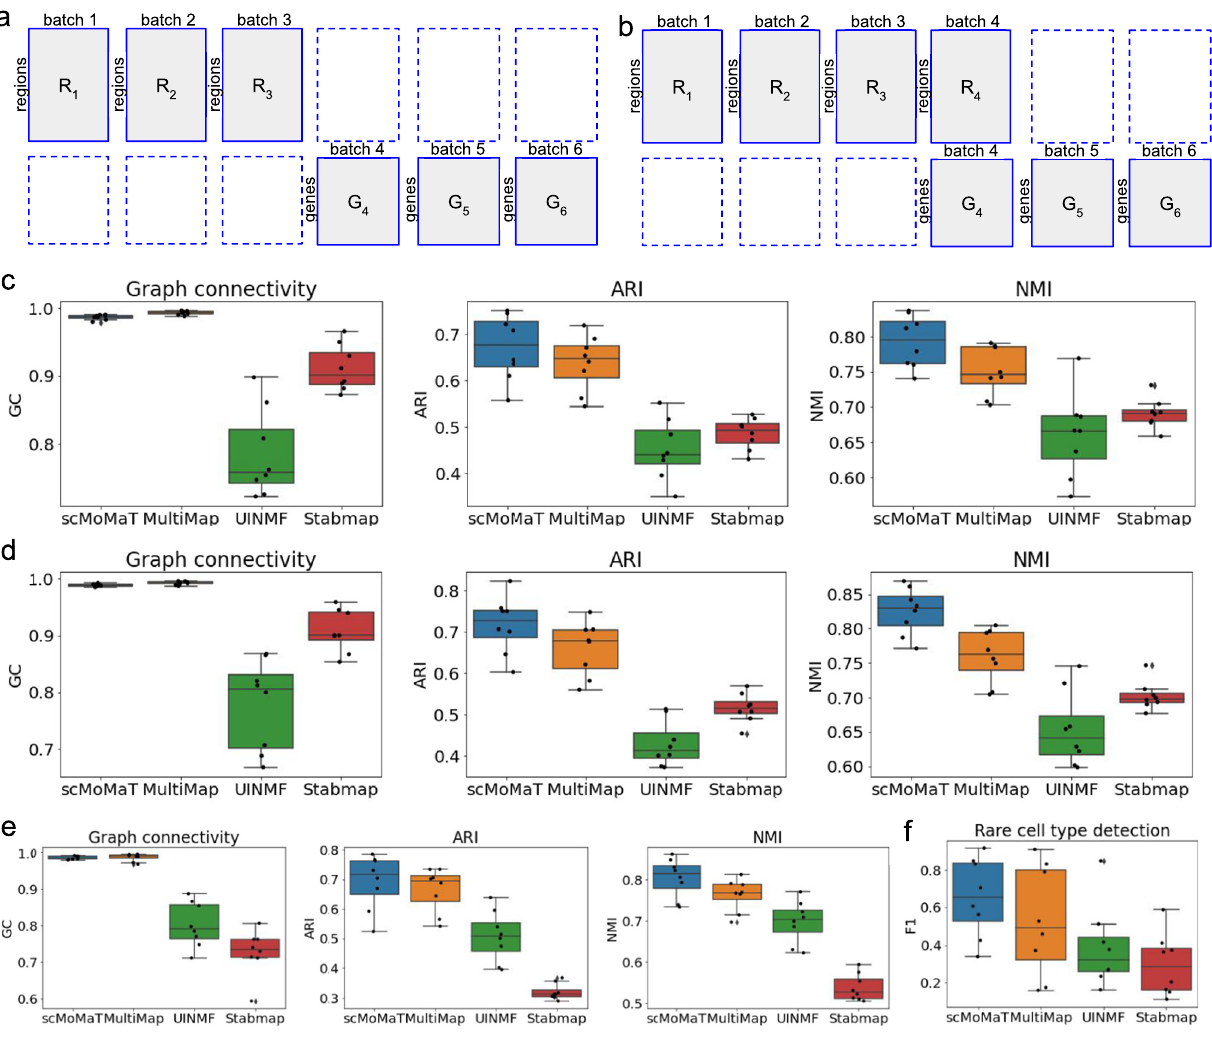
Fig.2|Resultsonsimulateddatasets.a Thelayoutofdatamatricesunderthe fi rst integration scenario. b The layout of data matrices under the second integration scenario. c GC, ARI, and NMI scores of scMoMaT and baseline methods under the fi rst integration scenario. d GC, ARI, and NMI scores of scMoMaT and baseline methods under the second integration scenario. e GC, ARI, and NMI scores of scMoMaTand baseline methodsunder datasetswithimbalanced batchsizes. f The